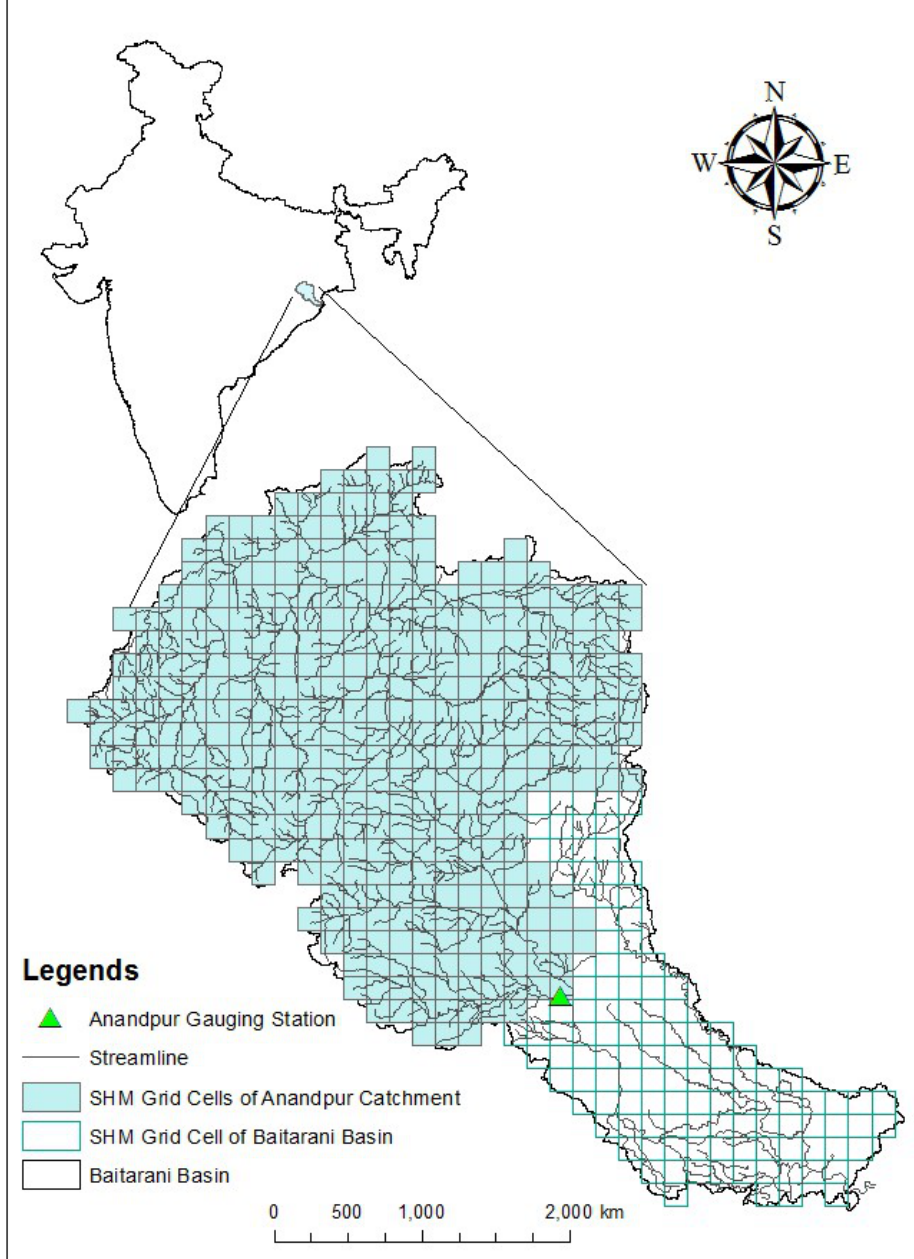
Figure 1. Index map of Baitarani river basin showing streamline and grid cells of SHM.